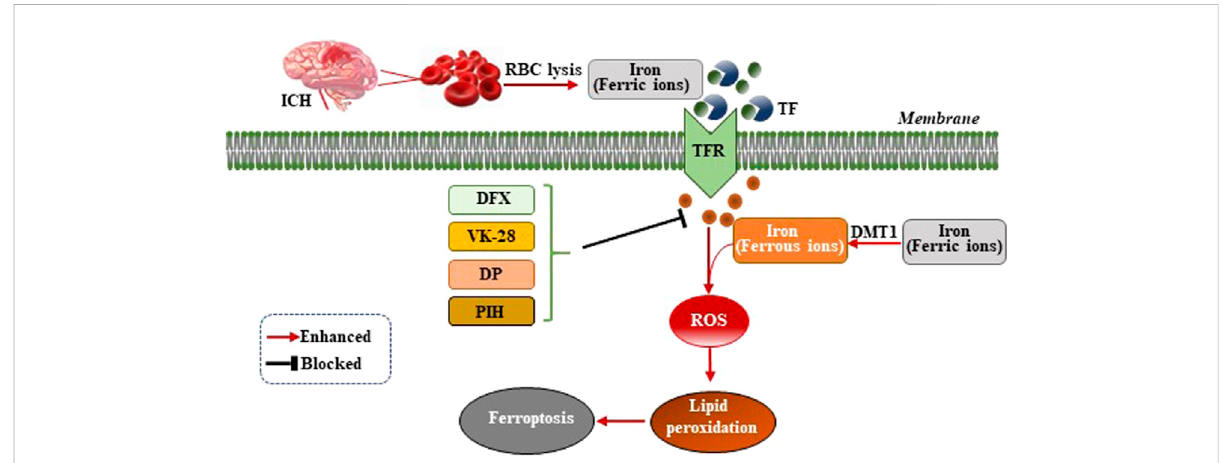
FIGURE 1 Mechanism of ferroptosis following ICH by intracellular iron overload. After ICH occurs, the hematoma releases iron ions from RBC lysis, the concentration of iron ions increase around neurons and combine with transferrin (TF) to transport iron ions into cells through TF receptor (TFR)- mediated effects. Ferric ions are reduced to ferrous ions by divalent metal transporter 1 (DMT1) and accumulate in neurons, where ferrous ions induceexcessivegenerationoflethalROSandlipidperoxides,therefore,resultinginferroptosis.Ironchelators(DFX,VK-28,DP,andPIH)forma chelating ferric amine with iron ions to prevent iron ions from donating electrons to oxygen to form ROS.